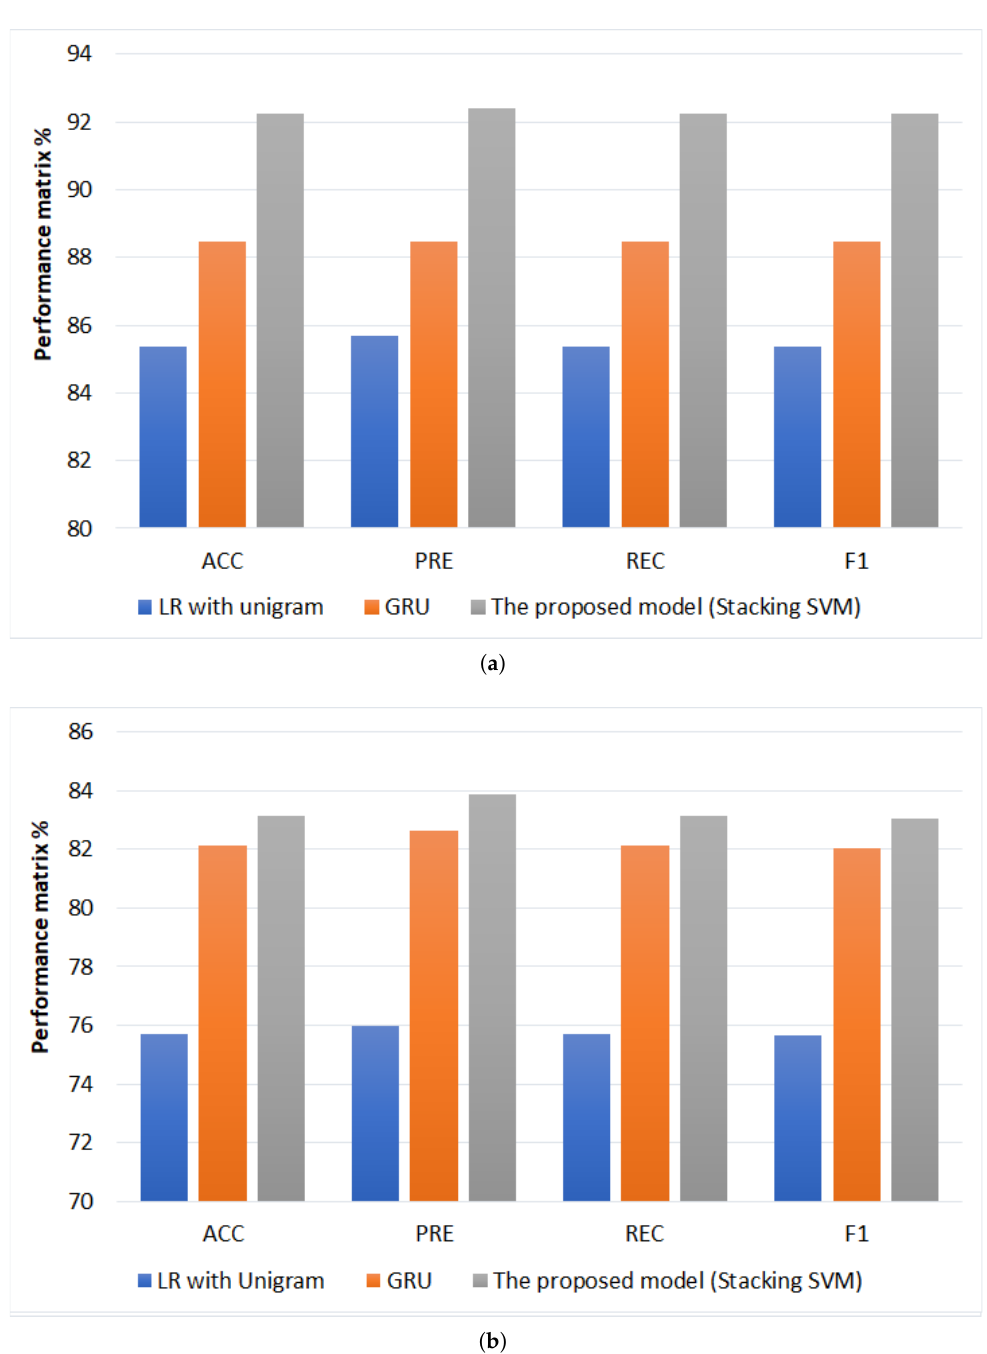
Figure 12. Comparison of performance the best models for ArTwitter, ( a ) Cross-validation perfor- mance and ( b ) testing